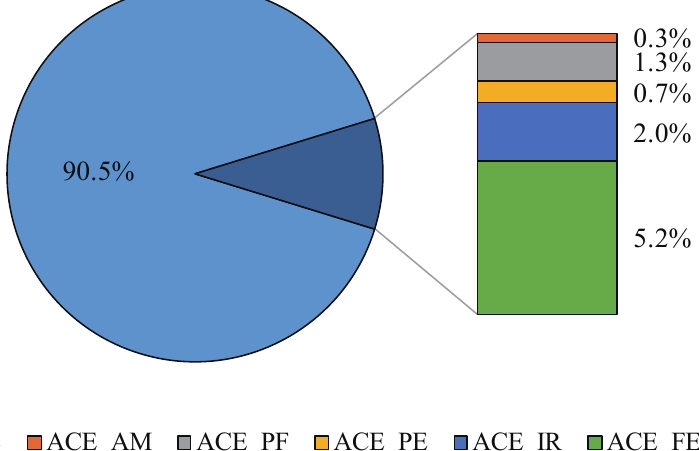
Figure 4. Average levels of the ACS and ACE, and the five components of the ACE in China (2019). We also calculate the national levels of the agricultural carbon emission and carbon sink which are the sum of the provincial values. For both of the two, the logarithm form is taken, shown in Figure 5. Compared between the two series, the ACS is always 10 times bigger than ACE ( ln ( ACS ) − ln ( ACE ) ≈ ln ( 10 ) = 2.3). For ACS, it is relatively stable before 2008 and increases from 2008 to 2015, and is basically unchanged after 2015. For ACE, there is a steady upward trend before 2015 and a steady downward trend after 2015. Although it is not shown here, data shows that this upward and downward trend is caused by the upward and downward trend in the use of the chemical fertilizer.